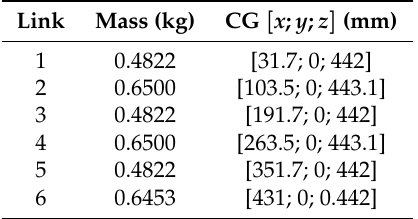
Table 2. Parameters of the 6-DoF redundant planar manipulator robot links.